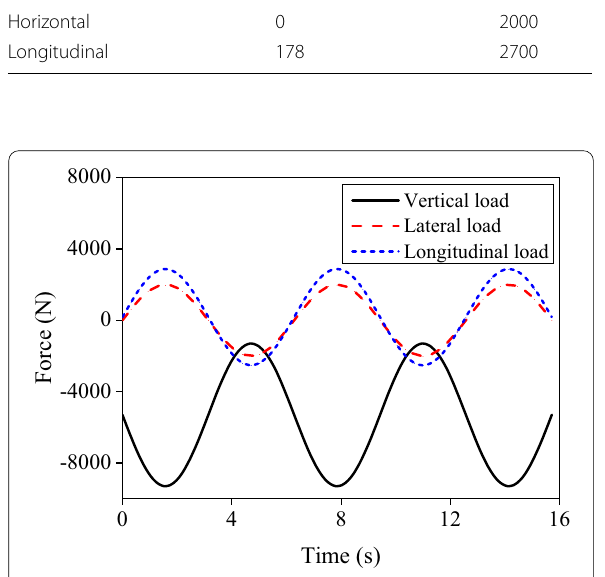
Figure 3 Tooling for the fatigue test of the cast aluminum beam and setup